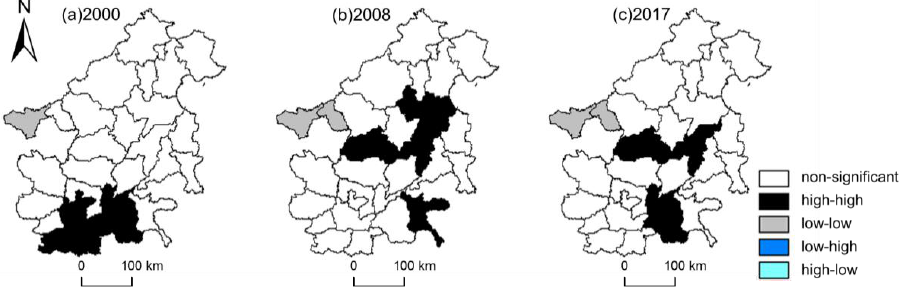
Figure 3. Cluster map of PM 2.5 in Beijing-Tianjin-Hebei region and surrounding cities in 2000, 2008 and 2017.